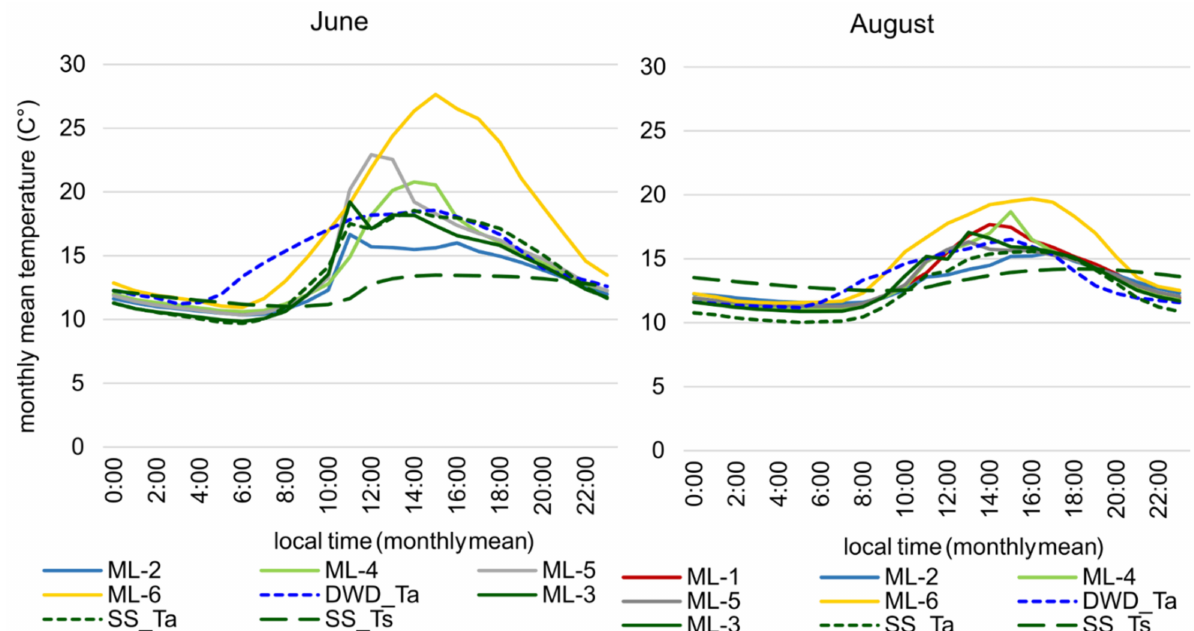
Figure 6. Averaged diurnal temperature courses in June and August 2014. Data from Micro-Loggers of type S1, from the Small Station (SS) and DWD station are shown. In 2014, June was warm and sunny, while August was cool and rainy compared to the long-term average.